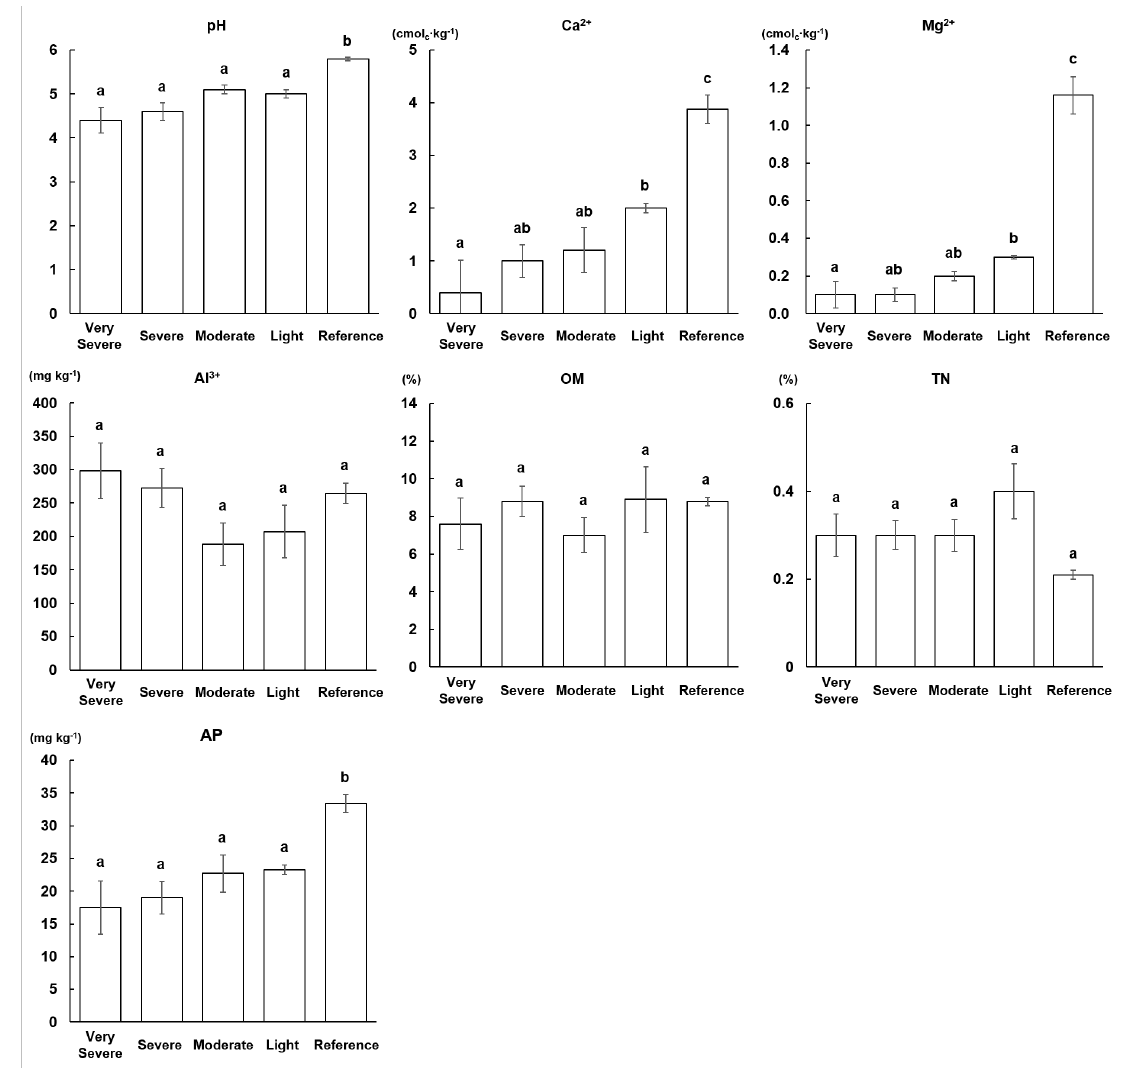
Figure 7. A comparison of the physic-chemical properties of the soil among damage degrees of vegetation and with that of the reference site. Very severe, severe, moderate, and light indicate damage degree and reference indicates the unpolluted site selected for comparison. OM: organic matter; TN: Total nitrogen; AP: available phosphorus. Each bar was expressed with mean and standard error of mean. Tukey’s honestly significant difference (HSD) test was conducted on each of the parameters that show a statistically significant difference among the four types of damage degrees at α = 0.05; the means with the same alphabetical character (in superscript), for each parameter, were not different from each